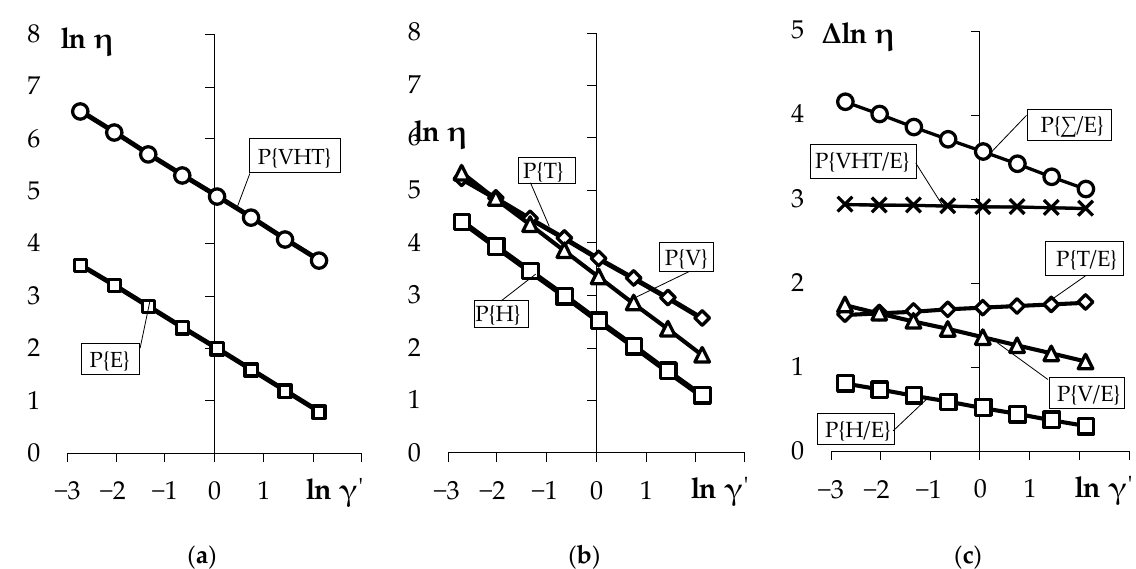
Figure 3. Logarithmic functions of the viscosity: ( a , b ) emulsions P; ( c ) increments of the logarithm of viscosity in relation to the reference emulsion P{E}.